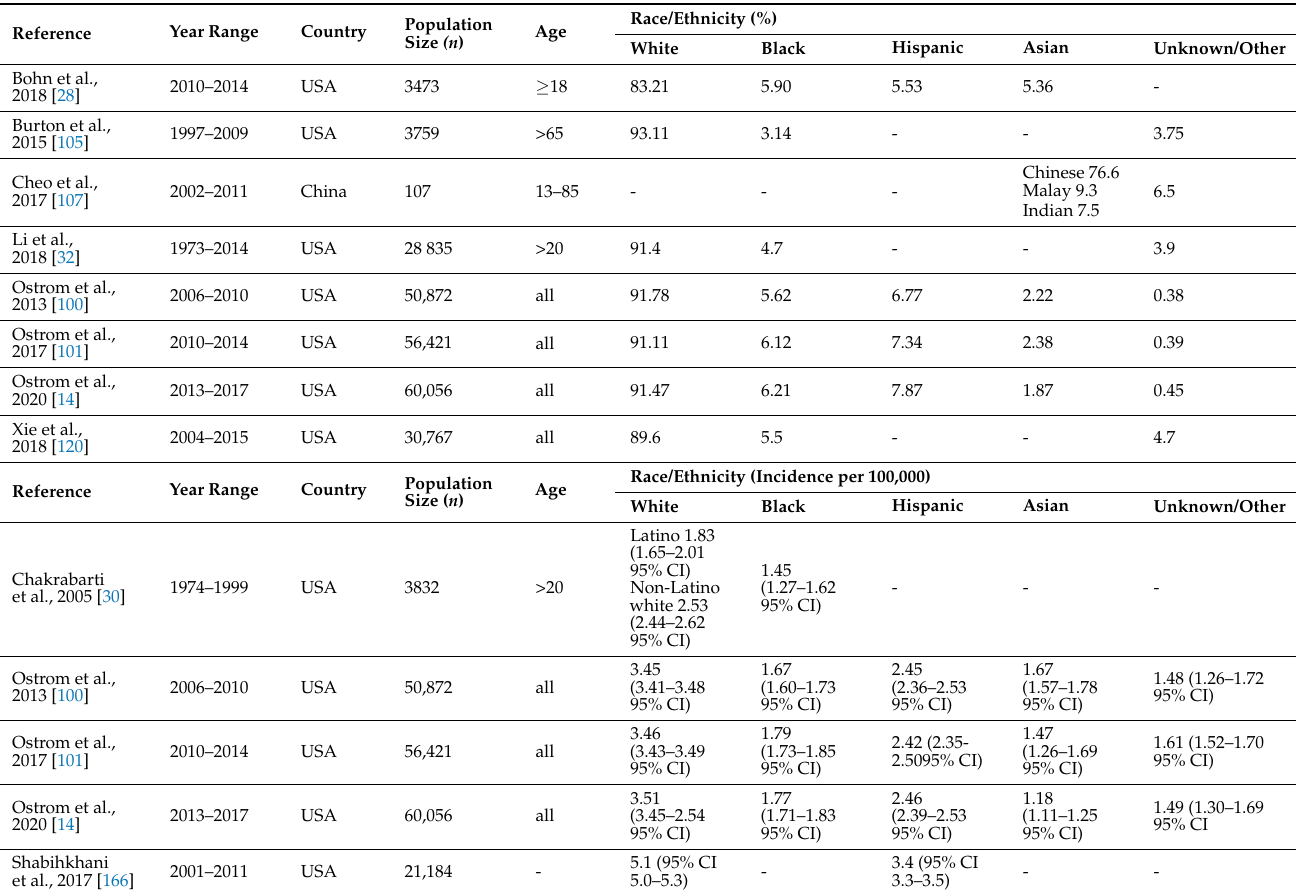
Table 4. Relationship between race/ethnicity and the incidence of